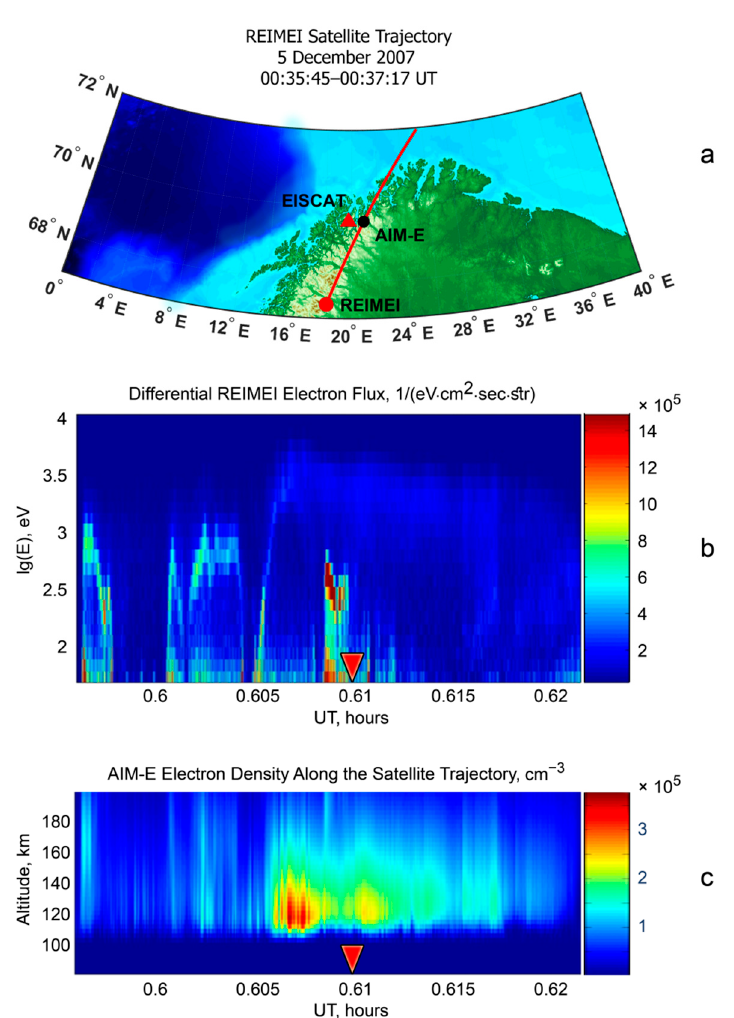
Figure 3. ( a ) REIMEI spacecraft trajectory on 5 December 2007 (00:35:45–00:37:17 UT (0.596–0.621 h)) projected to the 110 km height along the magnetic field lines with the IGRF-12 model; ( b ) REIMEI differential electron energy flux along the satellite trajectory in energy range from 60 eV to 11 keV; ( c ) AIM-E electron density values corresponding to REIMEI precipitation input electron flux measurements. Red triangles in ( b , c ) shows the moment of EISCAT and REIMEI conjugated measurements at 0:36:36 UT (0.610 h).